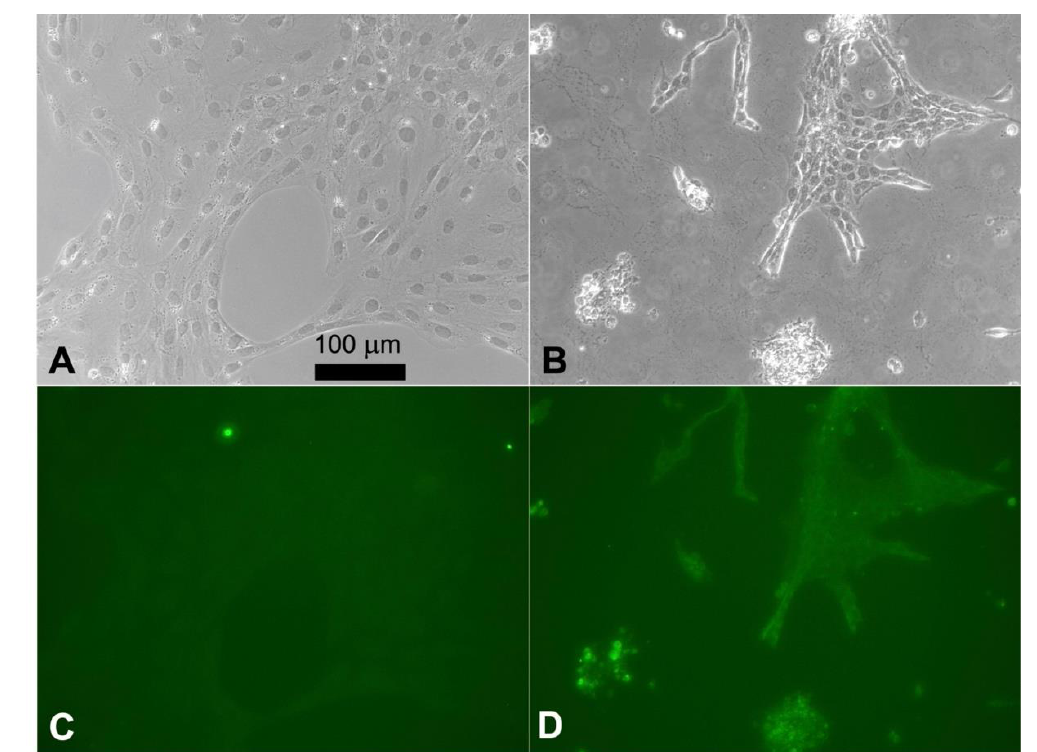
Figure 2. Human adipose-derived stem cells (ADSCs) on polyacrylamide gels. ( A , C ): ADSCs cultured on tissue culture plate for one week showed negative TUBB3 staining. ( B , D ): ADSCs cultured on polyacrylamide gel for one week showed positive TUBB3 staining.